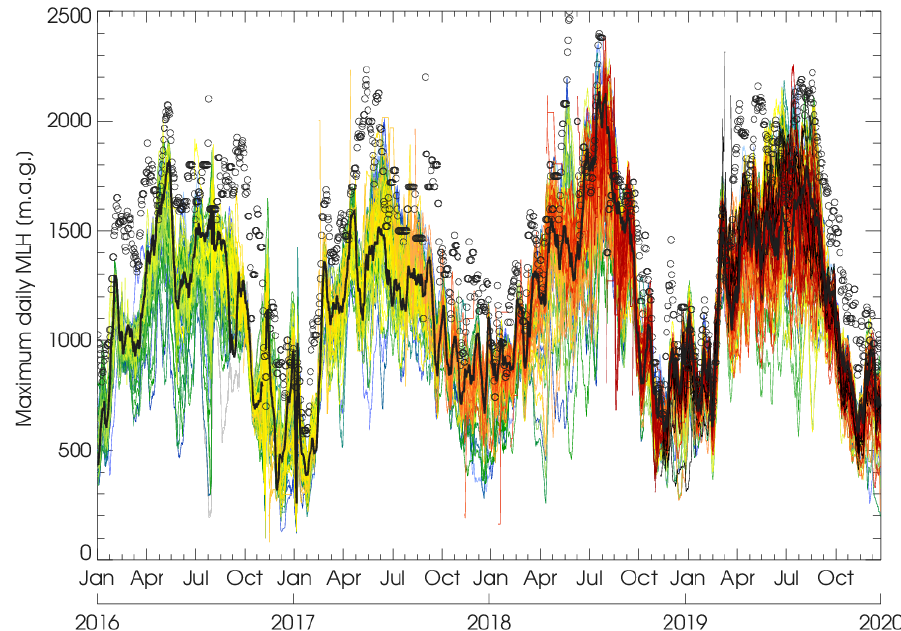
Figure 9. Maximum daily mixing layer height a.g. (MMLH) observed by the German ceilometers and extracted from the ECMWF NWP model for the period January 2016–December 2019. Different colors refer to model MMLH at different stations (colors shift from green to red because the number of stations increases over the years). The dots and the solid black line pick out the MMLH inferred around Alfeld (52.0 ◦ N, 9.9 ◦ E) manually from the daily ceilometer time–height plots and from the model fields,